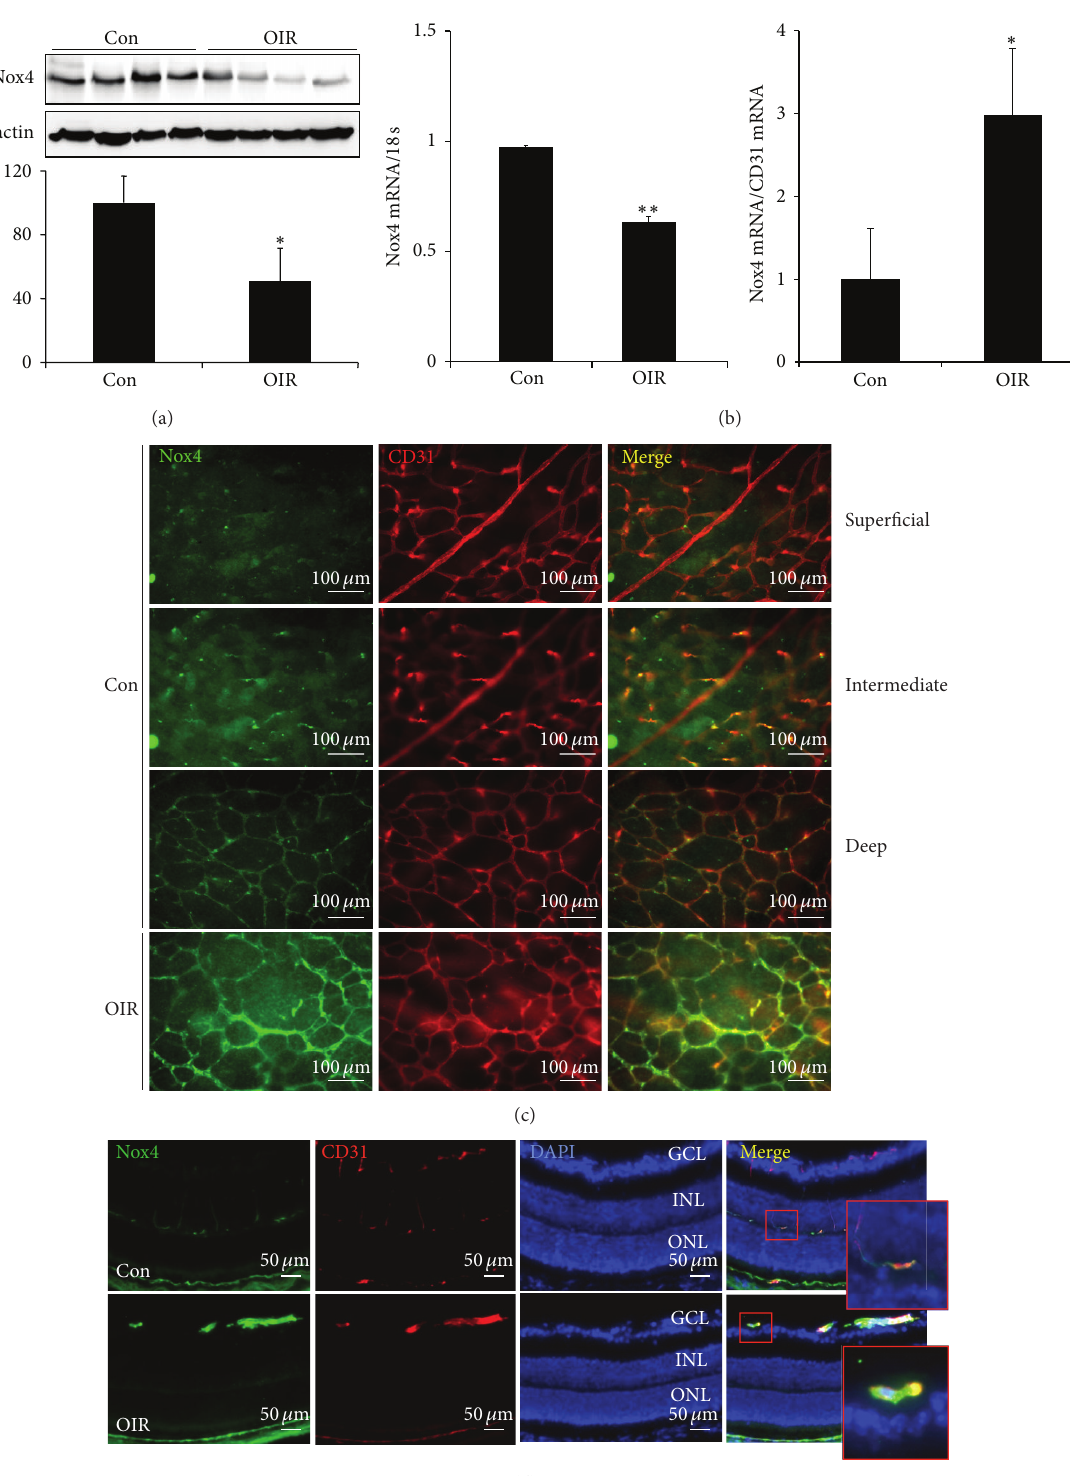
Figure 1: Nox4 expression in retinas from OIR and control mice at P12. (a) Expression of Nox4 protein in the retina in P12 OIR and control mice was determined by Western blot analysis and semiquantified by densitometry. 𝑛 = 4 for each group. (b) Expression of Nox4 mRNA in the retina in P12 OIR and control mice was determined by real-time RT-PCR and normalized to 18 s (left panel) or to CD31 (right panel). 𝑛 = 4 for control group and 𝑛 = 6 for OIR group. ∗ 𝑃 < 0.05 or ∗∗ 𝑃 < 0.01 versus Con. (c) Representative images of retinal whole mounts from P12 control mice stained with anti-Nox4 antibody (green) and anti-CD31 antibody (red). (d) Cryosections of eyeballs from P12 OIR and control mice were stained with anti-Nox4 antibody (green) and anti-CD31 antibody